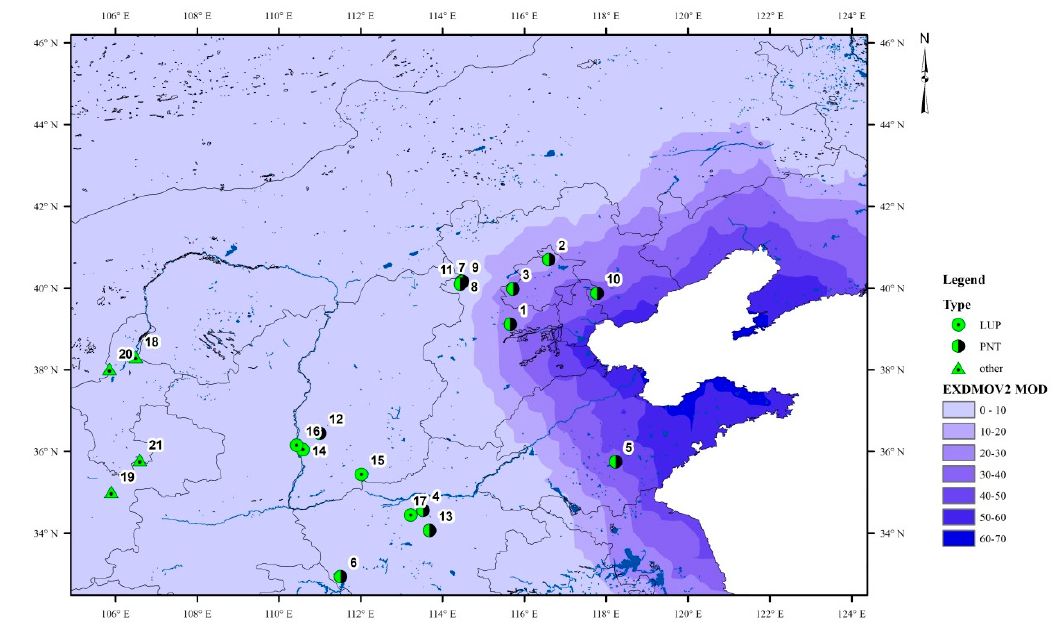
Figure 12. Archaeological sites dated to the Pleistocene–Holocene transition on the map of EXDMOV2 (expected distance of residential movement per year of hunter–gatherers with central location or who are primarily sedentary) in northern China under modern climatic conditions.